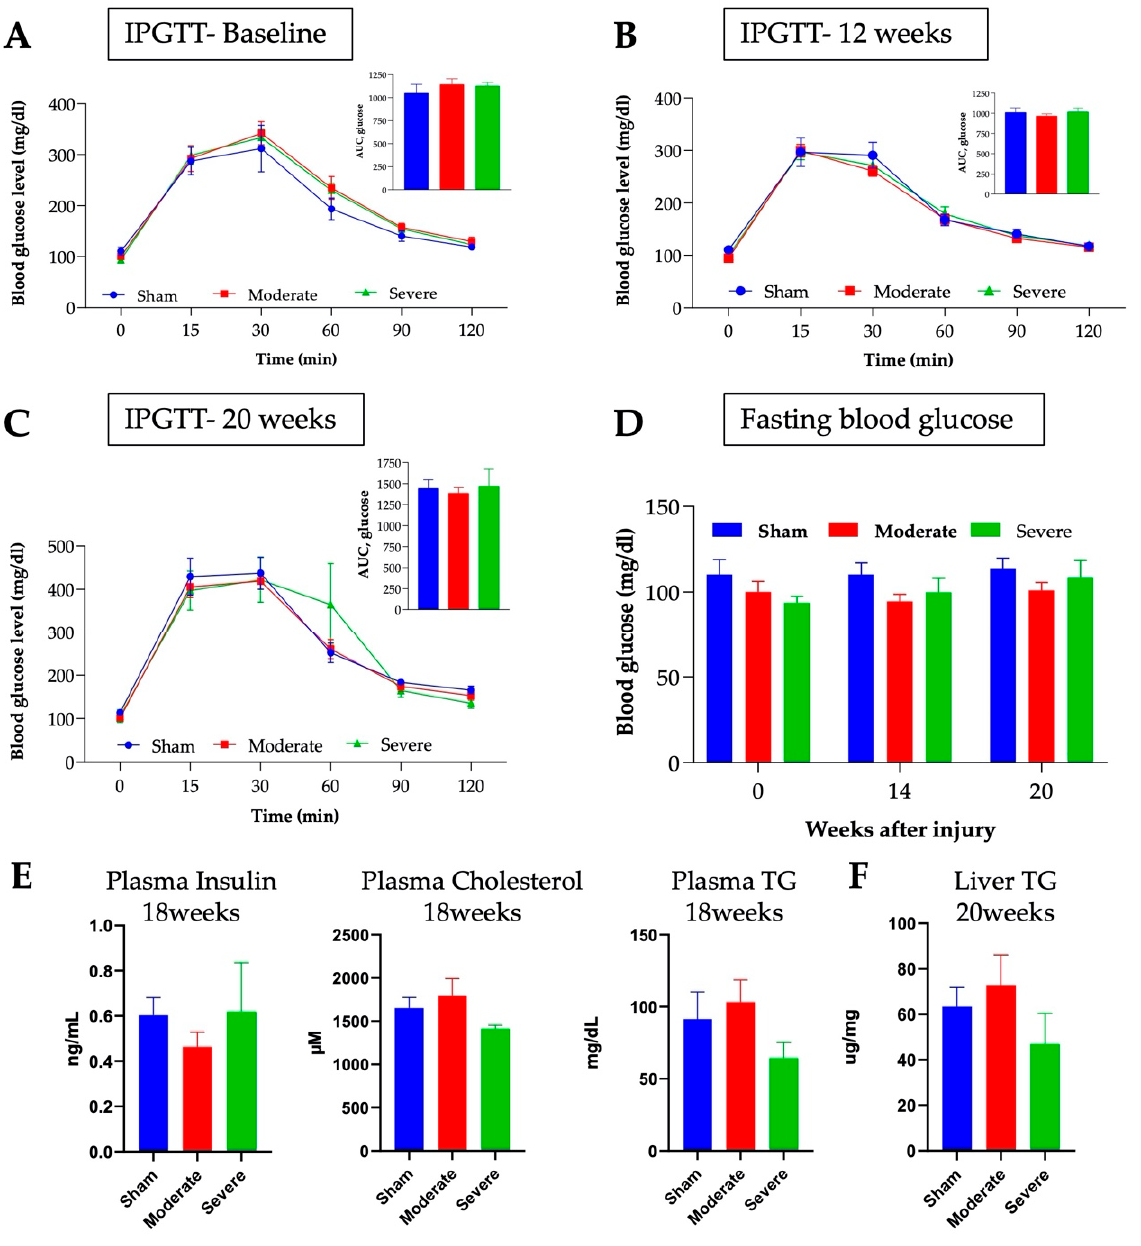
Figure 7. No changes in glucose metabolism after SCI regardless of the injury severity. IPGTT was performed pre-injury ( A ), at 12 weeks ( B ), and at 20 weeks PI ( C ). ( D ) Fasting blood glucose concentrations at different time points. No differences are observed for any of these measures. Plasma insulin, cholesterol, and triglyceride levels ( E ) were tested at 18 weeks PI. Liver triglyceride content ( F ) was assessed after euthanasia at 20 weeks PI. Values presented as mean ± S.E.M. N = 6 (sham), 8 (moderate), and 5–9 (severe). Data analyzed by two-way ANOVA or one-way ANOVA ( D – F ). * p < 0.05.